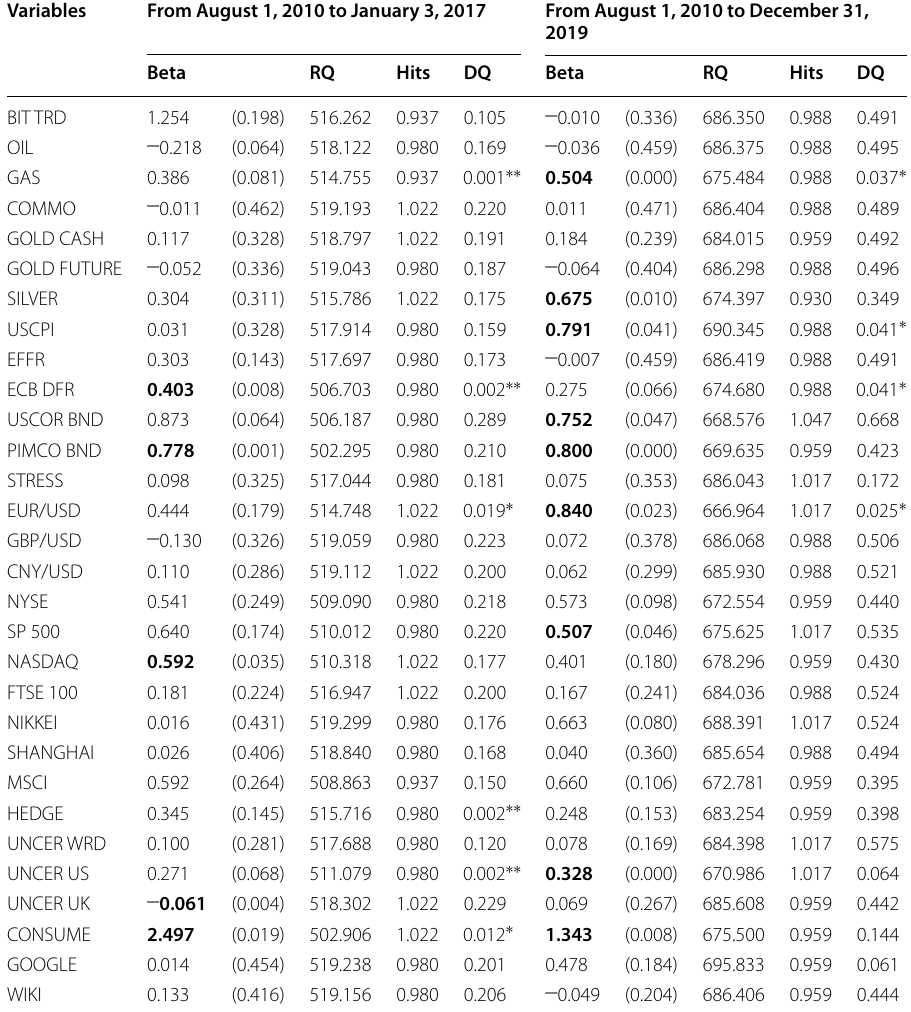
Table 6 Estimation results of the 1% CAViaRs with explanatory variables adopting symmetric absolute value